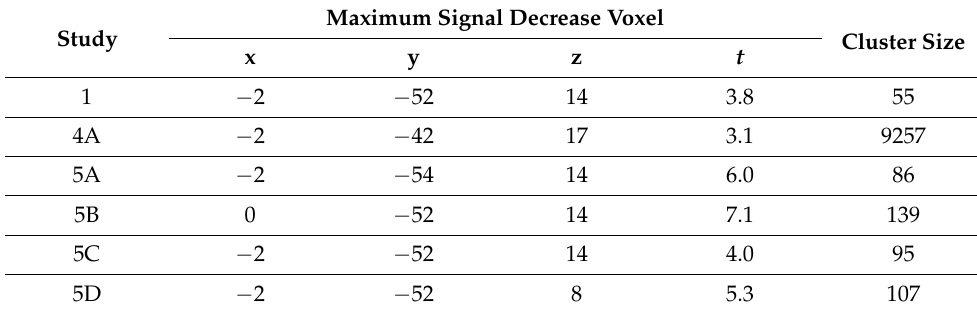
Figure 3. REM-locked fMRI signal decrease in RSC-Lt. The labels are the same as those in Figure 2. Each study constitutes an independent within-subject study. Yellow cross hairs are on the voxels of maximum signal decrease in RSC. Talairach coordinates and t values of the maximum deactivation voxels are shown in Table 3. Lines show location of the other views. Squares in the axial and coronal views are magnified. White vertical lines in the centers of the magnified views indicate the mid-sagittal plane. The squares in 5A–D were placed in the same location. All studies were thresholded at uncorrected p < 0.05 and additionally at a spatial extent of <5 contiguous voxels. The clusters were well circumscribed, 0.4~1.1 cm 3 . In all six studies, the clusters centered on the RSC-Lt. REM-locked activation maps are overlaid in 5A to show that RSC deactivation is surrounded by activation. Two further studies (4B and 7) also showed circumscribed REM-locked signal decrease near RSC-Lt, but this was not included because the majority of these fell on cerebrospinal fluid (CSF) areas. Table 3. REM-locked fMRI signal decrease in